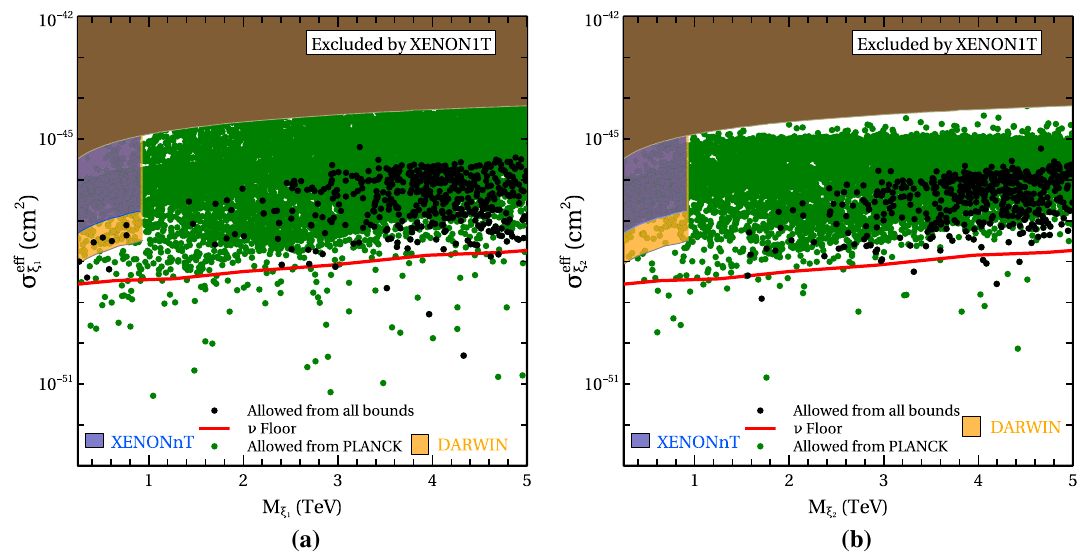
Fig. 5 Effective spin-independent direct detection scattering cross- section of individual DM candidates. Green points are satisfying the boundedness of potential, perturbativity of couplings and the total DM